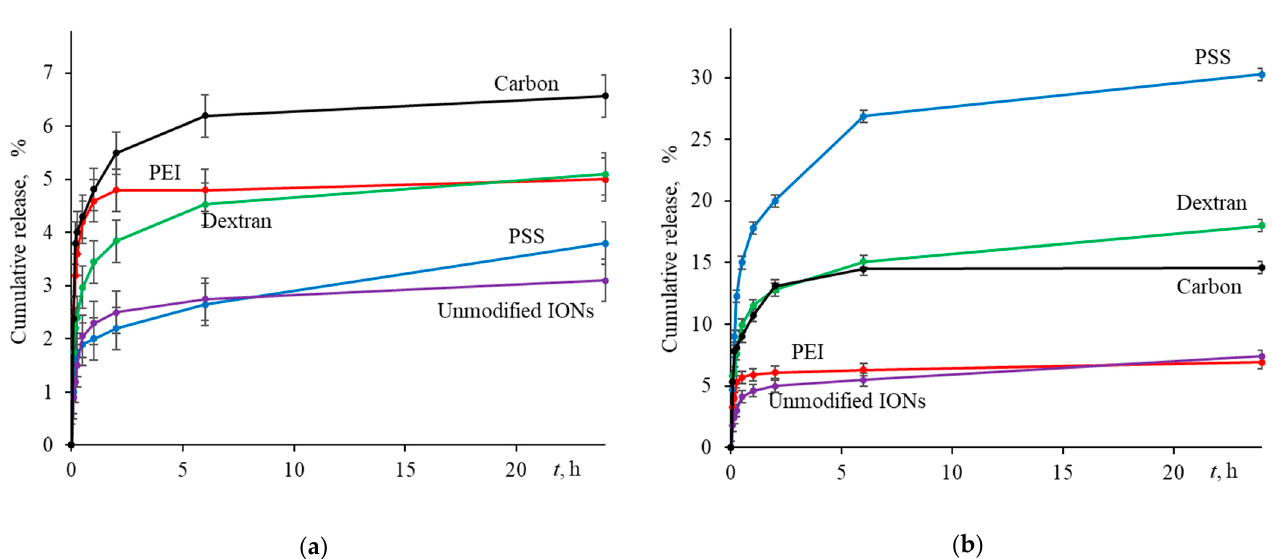
Figure 7. Payload release from drug-loaded nanosorbents in buffer solution at ( a ) pH 7.4 and ( b ) pH 5.0 as a function of time ( n = 3, p = 0.95).